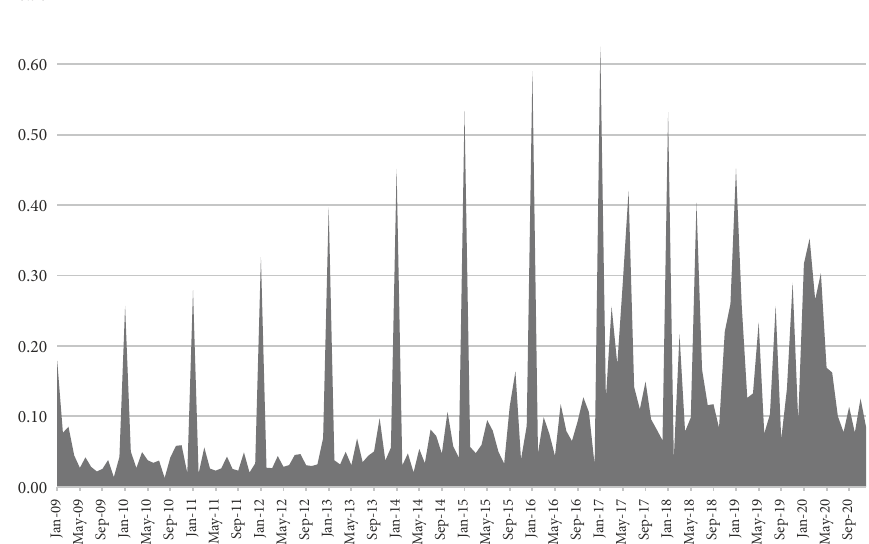
Figure 4. Regional Barometer of Protectionism for Poland (monthly index between January 2009 and December 2020) (source: authors’ own calculations, 2022)